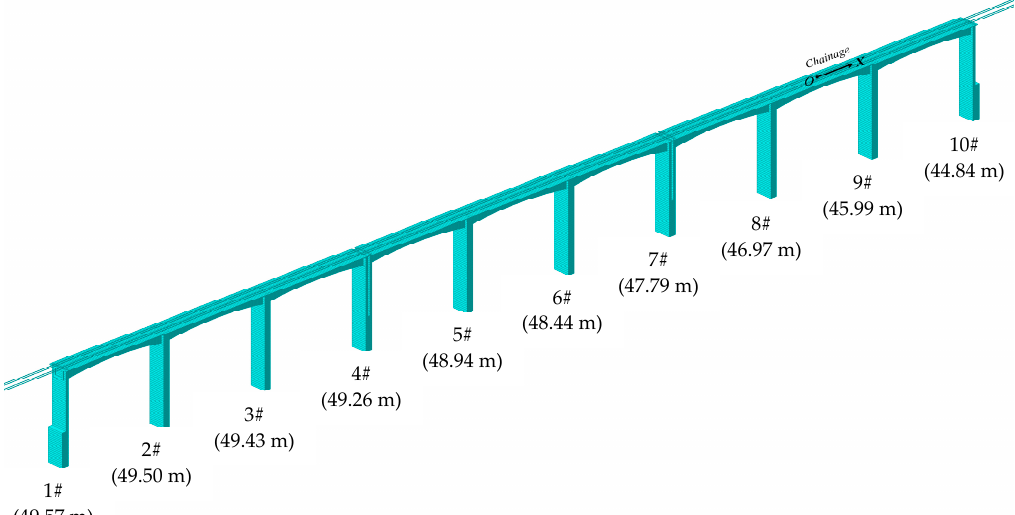
Figure 7. Integrated finite element (FE) model for track–bridge analysis.